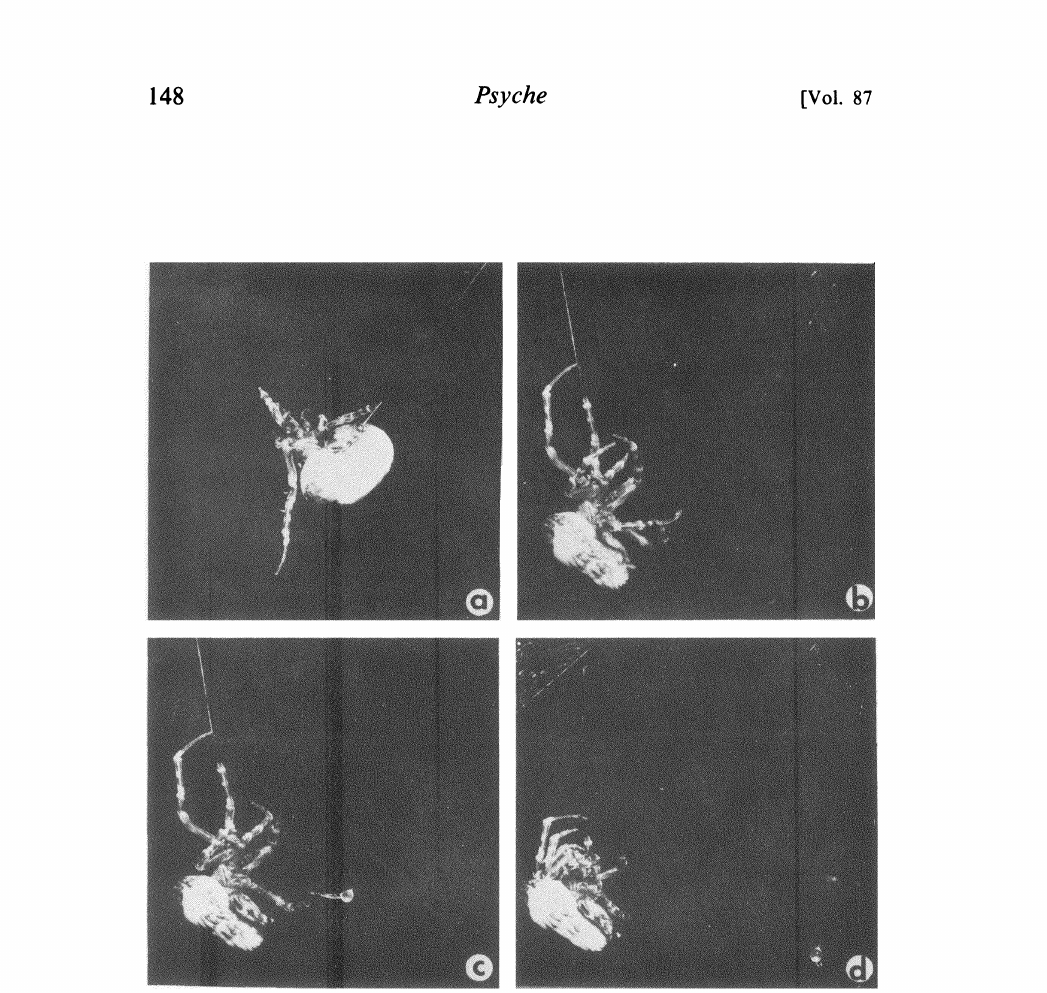
Fig. 10. Construction of a sticky ball. A. Spider moves horizontally, waving her front legs actively in the space where she will produce and swing her bolas. Probably this behavior serves to sense the presence of objects which would interfere with hunting behavior. B. Spider hangs from the horizontal trapeze line and begins to pull sticky silk from her spinnerets onto the bolas line which is attached above to the trapeze line. C. Spider continues to produce sticky silk and the sticky ball grows. D. The last of the sticky silk has been produced and it is slowly absorbed into the ball as the ball hangs free. The spider then walks across the trapeze line, grasps the bolas line, and assumes the hunting